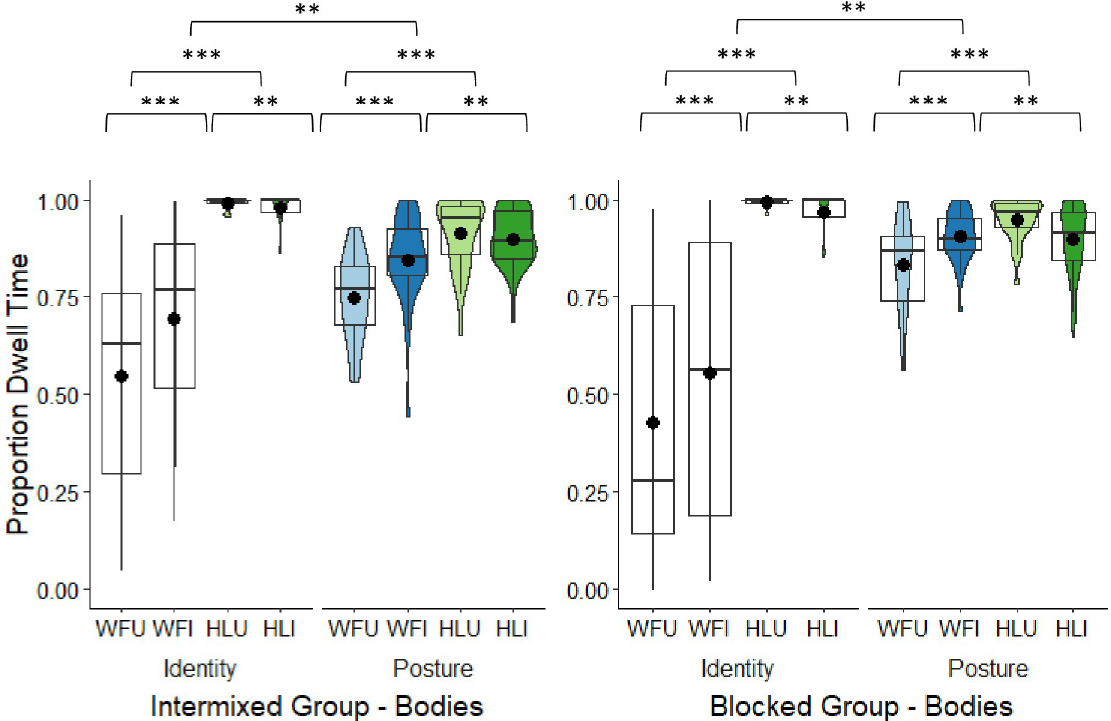
Fig 7. Intermixed and blocked groups’ box and violin plots of dwell time (DT) proportions (outliers removed) to the bodies in the whole figure upright (WFU), whole figure inverted (WFI), headless upright (HLU), and the headless inverted (HLI) conditions in the identity and posture tasks; dots denote means; ��� = p < .001; �� = p <